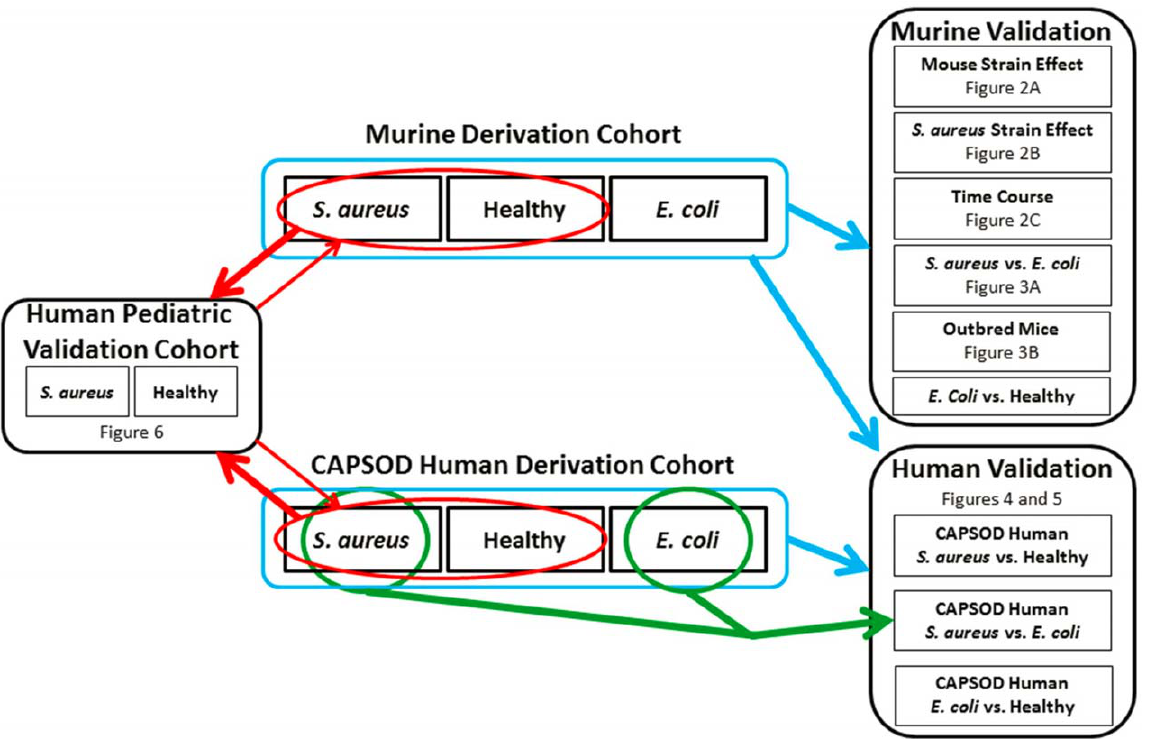
Figure 1. Schematic of derivation and validation cohorts. The Murine Derivation Cohort includes S. aureus infection (n=83), healthy control mice (n=54), and E. coli infection (n=50). It served as a validation cohort to assess Mouse Strain Effect, S. aureus Genetic Background Effect, Time Course, and to compare S. aureus vs. E. coli and E. coli vs. Healthy. The murine S. aureus classifier was externally validated in Outbred Mice (n=30) and the CAPSOD Human Cohort. The CAPSOD Human Cohort includes S. aureus BSI (n=32), healthy volunteers (n=43), and E. coli BSI (n=19). It served as a validation cohort to compare S. aureus vs. Healthy, S. aureus vs. E. coli , and E. coli vs. Healthy. Model derivation and validation using the entire cohort of animals or humans is depicted by the blue outline and arrows. An independent classifier was generated using only subjects with S. aureus or E. coli BSI (green outline). This classifier was validated using leave one out cross validation (green arrow). The Human Pediatric Cohort (n=46 S. aureus , 10 Healthy) used for external validation does not include patients with E. coli infection. Therefore, S. aureus classifiers were generated from the murine and CAPSOD cohorts that excluded E. coli data (red outline and thick red arrow). The Human Pediatric Cohort was used to derive a Human S. aureus vs. Healthy classifier which was validated in the S. aureus -infected and Healthy populations within the murine and CAPSOD human cohorts (thin red arrow).